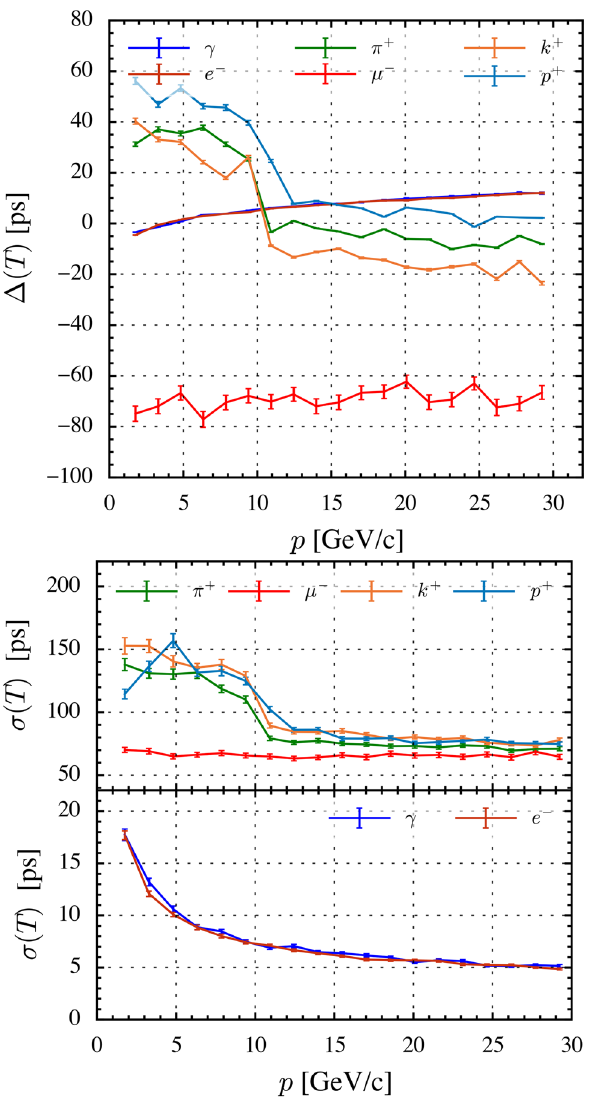
Fig. 11 With R = 0 . 4, the time reconstruction bias (top) and reso- lution (bottom) of e − , μ − , π + ,K + and p as a function of the incident momentum